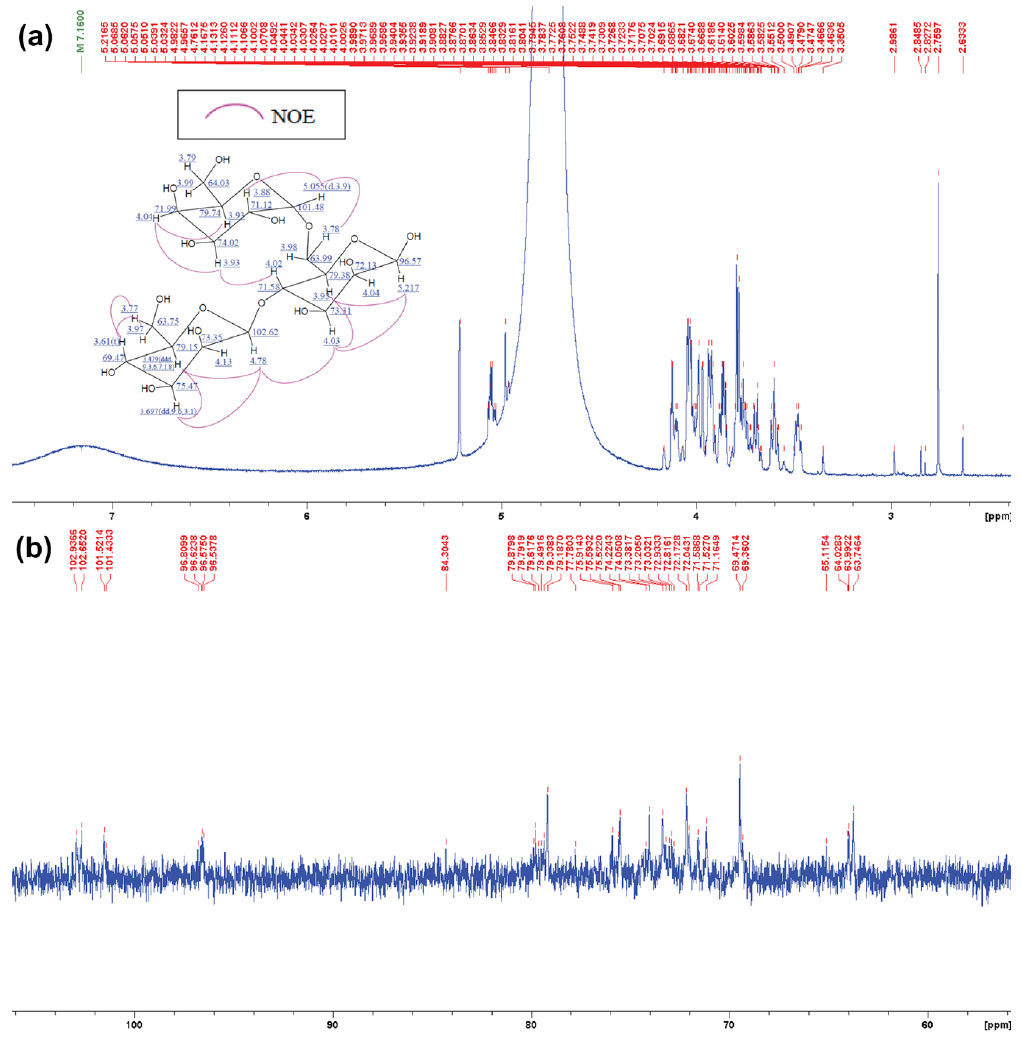
Figure 6. NMR analysis of P Af GLAF35 hydrolytic product, m-3. ( a ) 1 H NMR of m-3 and ( b ) 13 C NMR spectra of m-3. Predicted structure of m-3 is provided within Figure 6b.